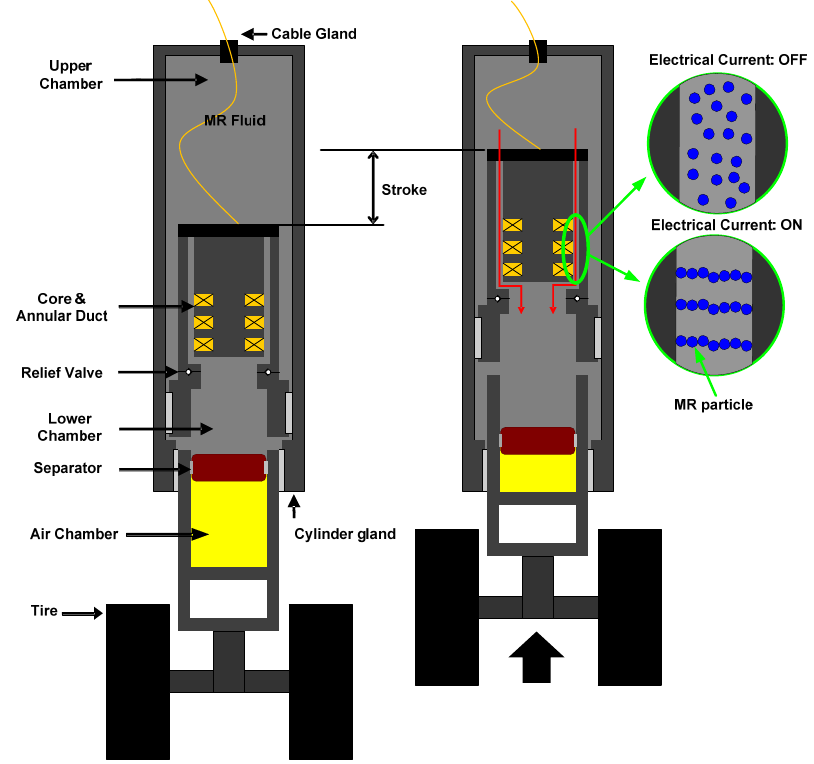
Figure 1. Landing gear equipped with an MR